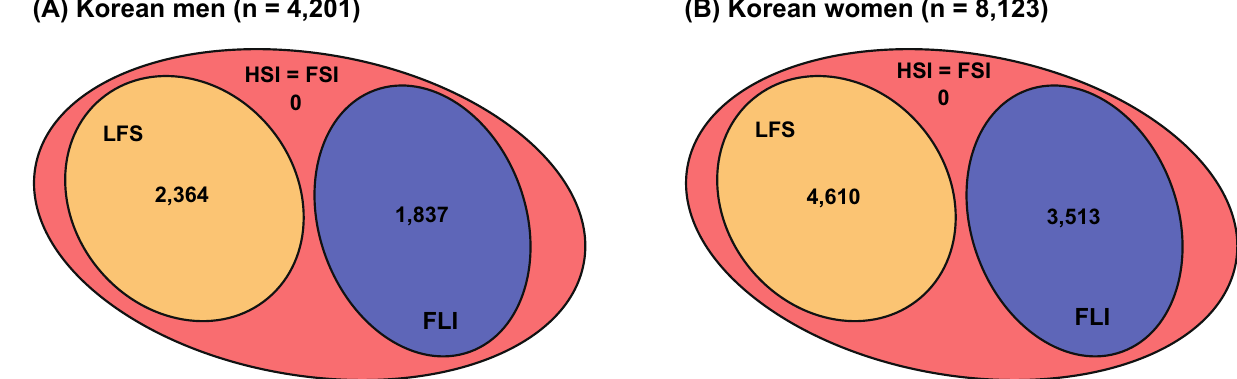
Figure 1. Comparison among scoring indices for fatty liver. Numeric values indicate the number of subjects with indices for fatty liver in men ( A ) and women ( B ). HSI hepatic steatosis index, FSI Framingham steatosis index, LFS NAFLD liver fat score, FLI fatty liver serum glucose and insulin, total cholesterol, triglycerides, AST, ALT, GGT, and serum creatinine and also higher rates of LSMI, hypertension, type 2 diabetes, and obesity (Table 3). The two variables, PA and CVD, had a non-